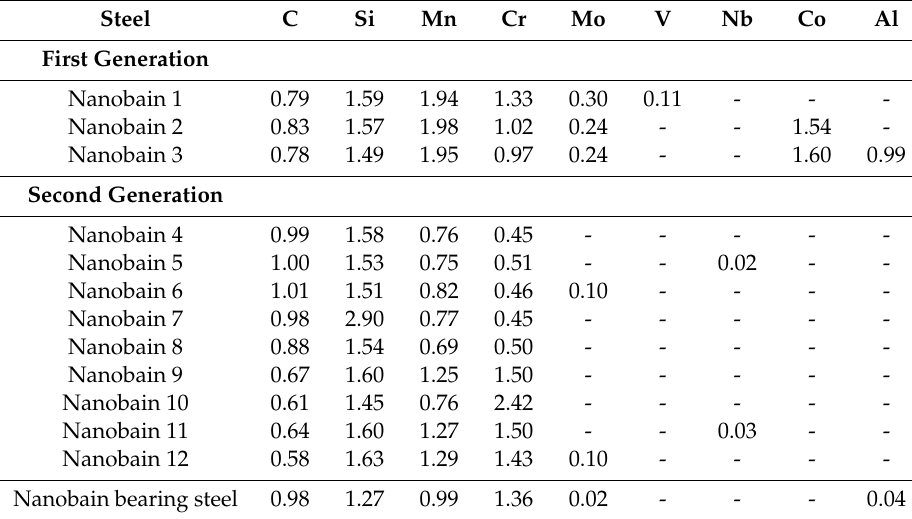
Table 2. Chemical composition of nano-scale bainitic steels, wt.% [8].